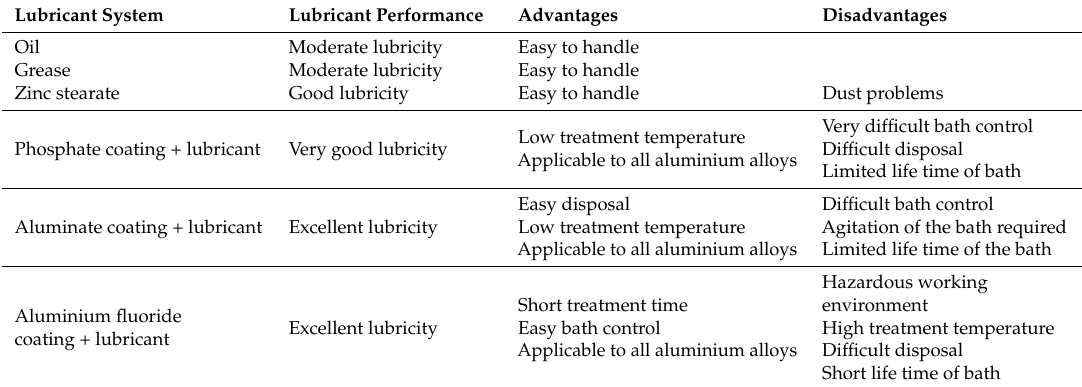
Table 7. Advantages and disadvantages of different lubrication systems for cold forging of aluminium